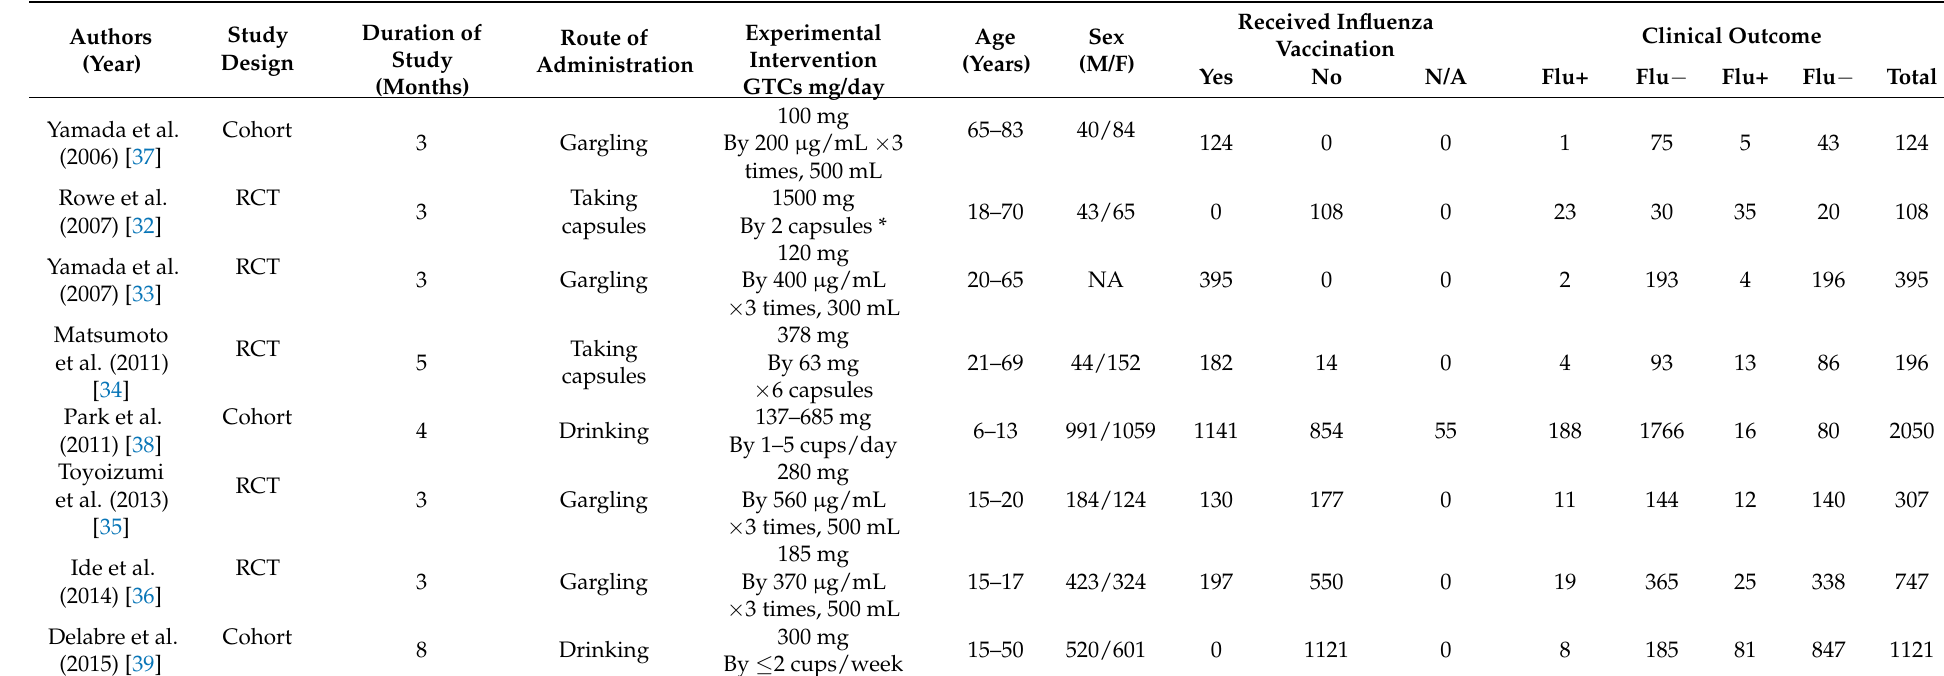
Table 1. Characteristics of the included